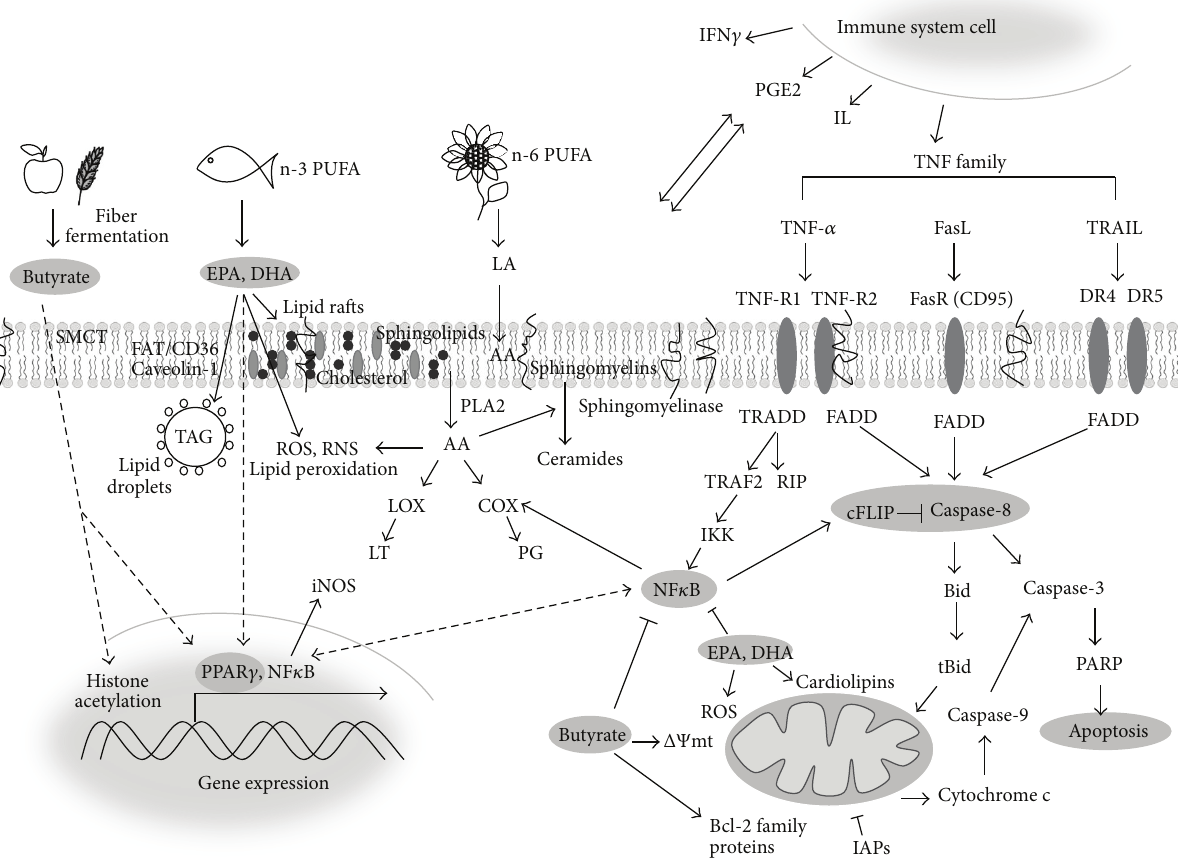
Figure 1: Schematic simplified demonstration of the main mechanisms supposed to be involved in fatty acid and TNF family interaction at different levels of colon epithelial cell organisation. Fibre fermentation product butyrate is transported by SMCT into the cells, where it may inhibit histone deacetylation, activate transcription factor PPAR 𝛾 , inhibit NF 𝜅 B, and affect ΔΨ mt and expression and balance of pro- and antiapoptotic members of Bcl-2 family proteins. Dietary PUFAs of the n-6 (LA, AA-plant oils) and n-3 series and (EPA and DHA, fish and algal oils) transported into the cells by FAT/CD36 are stored in lipid droplets in TAG form or incorporated into plasma and mitochondrial membrane lipids thus modulating composition and structure of lipid rafts and caveolae. PUFAs are released from membrane phospholipids by PLA2 and metabolized by COX and LOX enzymes to various types of products such as LTs and PGs. PUFAs can also modulate ceramide production and their metabolism is source of ROS and RNS and induces lipid peroxidation. Incorporation of PUFAs into mitochondrial cardiolipins influences mitochondrial metabolism and induction of apoptosis. EPA and DHA activate PPAR 𝛾 and inhibit NF 𝜅 B, thus suppressing iNOS expression and RNS production. TNF family cytokines TNF- 𝛼 , TRAIL, and FasL bind to their receptors TNFR1 and 2, DR4 and DR5, or FasR (CD95), respectively. Programmed cell death is regulated by formation of DISC consisting of FADD and procaspase-8, whose activation may be inhibited by cFLIP. Cleavage of Bid protein to tBid mediates connection between extrinsic and intrinsic (mitochondrial) apoptotic pathway. Changes in mitochondria (involving cardiolipin modulation), mitochondrial transition pore opening,decreaseof ΔΨ mt,andproductionofROSinfluencetheactivationofpro-andantiapoptoticproteinsoftheBcl-2familyandreleaseof proapoptotic proteins (e.g., cytochrome c) into the cytosol. Subsequent activation of caspase-9 and caspase-3, cleavage of PARP, and execution of apoptosis can be inhibited by IAPs. TNF- 𝛼 activates NF 𝜅 B via pathway involving TRADD, RIP, TRAF2, and IKK proteins. The interaction between epithelial cells and cells of immune system, which are the source of inflammatory mediators (IFN 𝛾 , IL, and PGE2), is also indicated. The dashed arrows-simplified signalling pathways. AA: arachidonic acid; cFLIP: FLICE-like inhibitory protein; COX: cyclooxygenase; ΔΨ mt: mitochondrial membrane potential; DHA: docosahexaenoic acid; DISC: death-inducing signaling complex; DR: death receptor; EPA: eicosapentaenoic acid; FADD: Fas-associated DD protein; FasL: Fas ligand; FasR: Fas receptor; FAT/CD36: fatty acid translocase; IAPs: inhibitor of apoptosis proteins; IKK: inhibitor of NF 𝜅 B kinase; IFN 𝛾 : interferon 𝛾 ; IL: interleukin; iNOS: inducible nitric oxide synthase; LA: linoleic acid; LOX: lipoxygenase; LT: leukotrienes; NF- 𝜅 B: nuclear factor 𝜅 B; PARP: poly-ADP ribose polymerase; PG: prostaglandins; PGE2: prostaglandin E2; PLA2: phospholipase A2; PPAR 𝛾 : peroxisome proliferator-activated receptor 𝛾 ; PUFA: polyunsaturated fatty acids; transporters; TNF: tumor necrosis factor; TNFR: tumor necrosis factor receptor; TRADD: TNFR1-associated death domain protein; TRAF2: TNF receptor-associated factor 2; TRAIL: tumour necrosis factor-related apoptosis-inducing